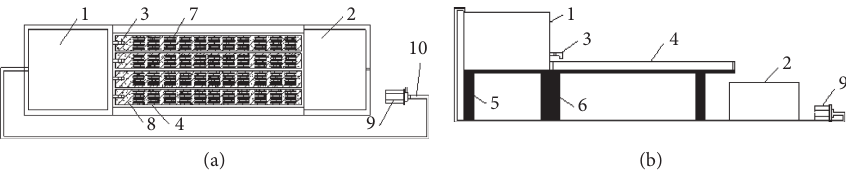
Figure 2: Schematic diagram of the flowing water erosion test device: (a) vertical view; (b) lateral view (1, upper water tank; 2, lower water tank; 3, water flow control valve; 4, water channel; 5, upper water tank support platform; 6, water channel support platform; 7, specimen; 8, sand cushion; 9, water pump; 10, water pipe).